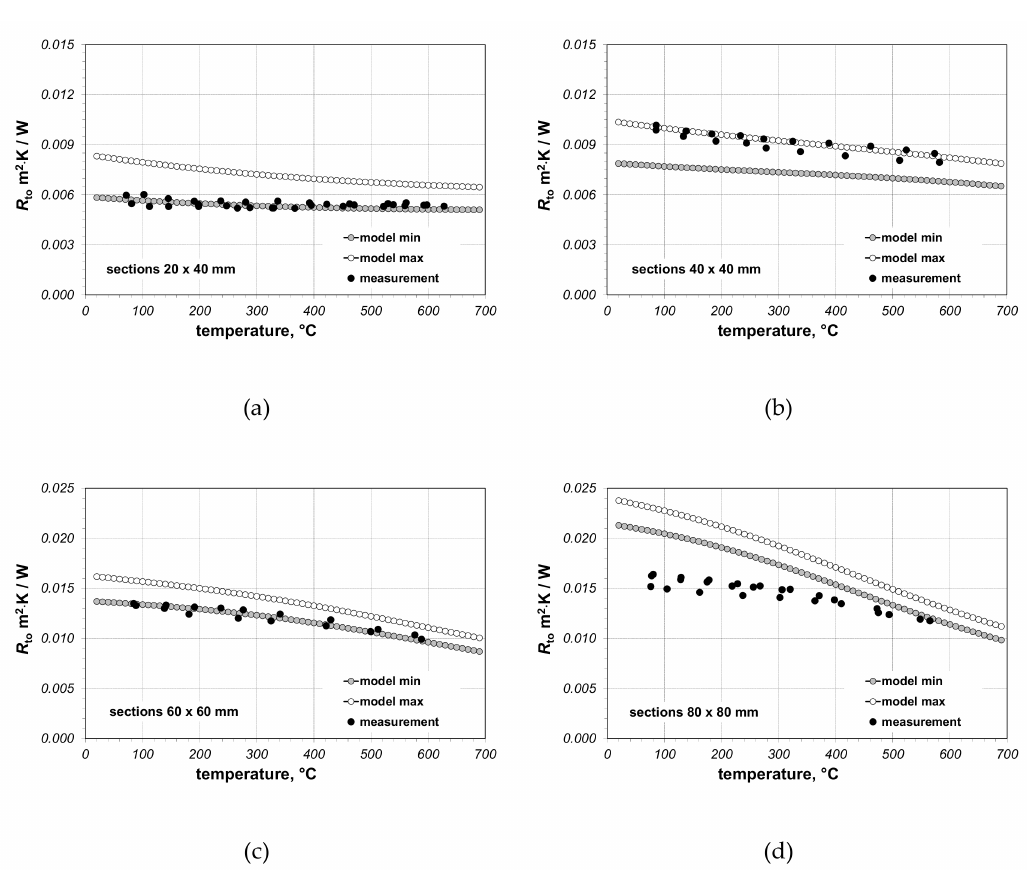
Figure 10. The results of model calculations and the measurements of the total thermal resistance of packages of rectangular steel sections: ( a ) sections 20 × 40 mm, ( b ) sections 40 × 40 mm, ( c ) sections 60 × 60 mm, ( d ) sections 80 × 80